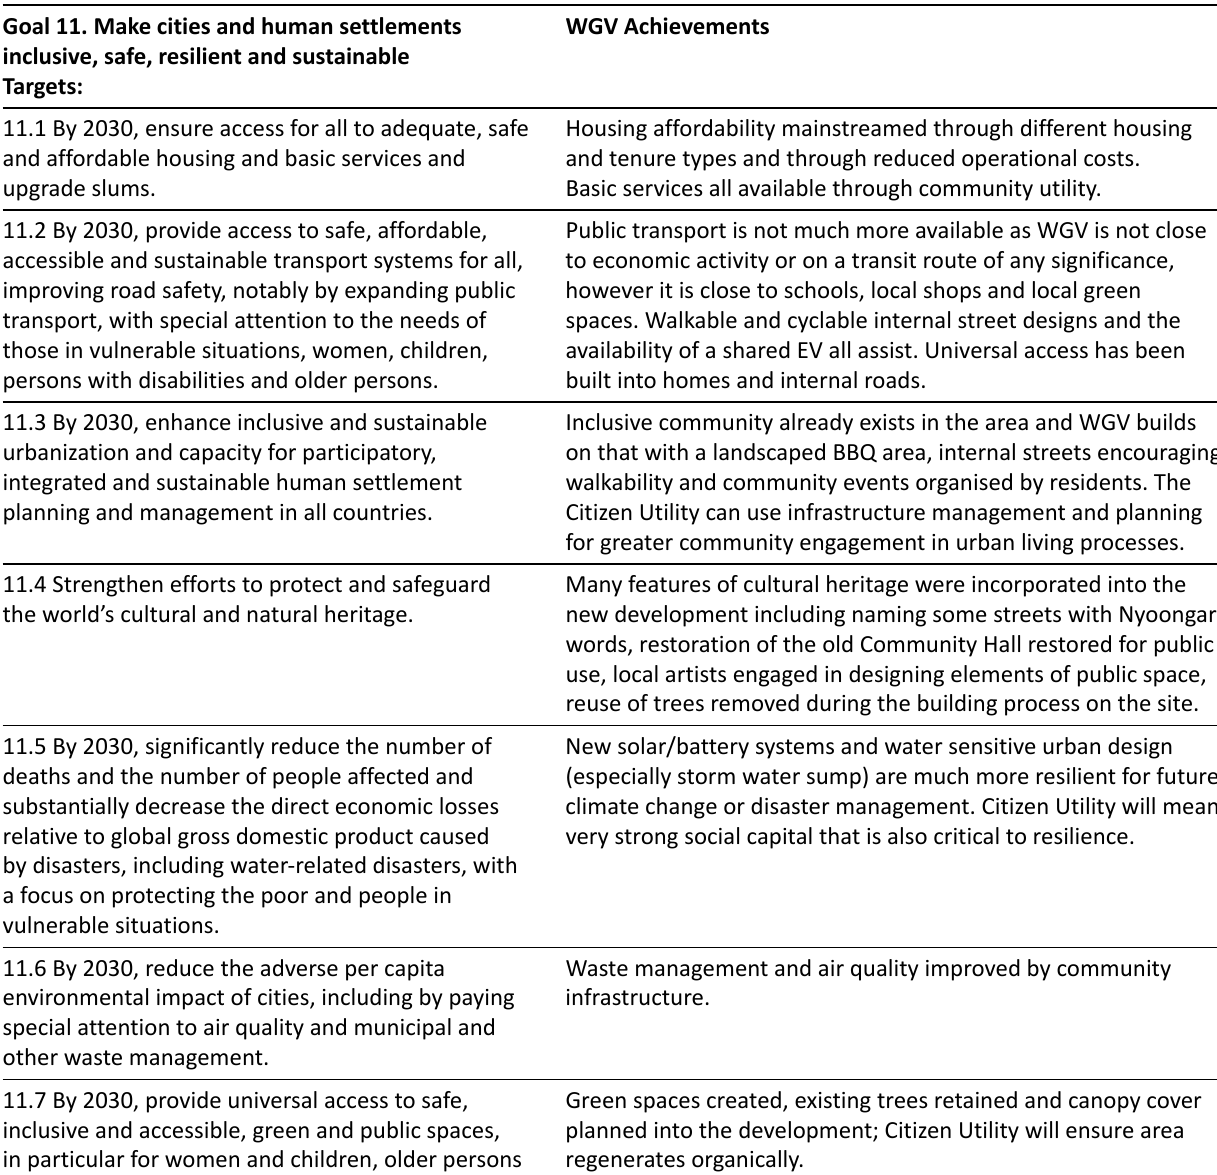
Table 3. Urban SDG indicators and how they apply to WGV. Goal 11. Make cities and human settlements WGV